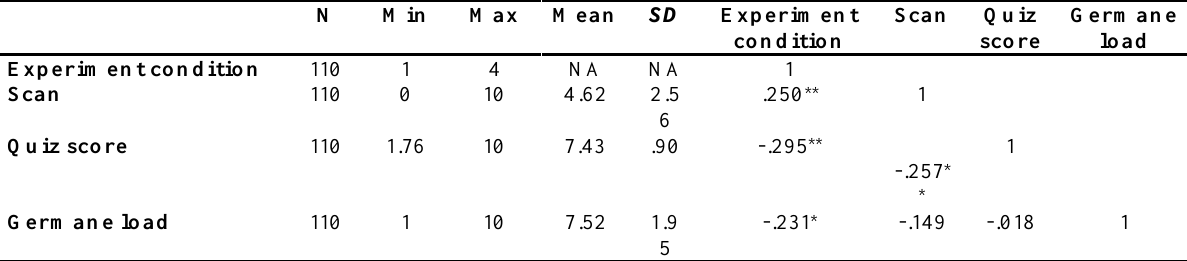
Descriptive Statistics and Correlations Between the Main Variables